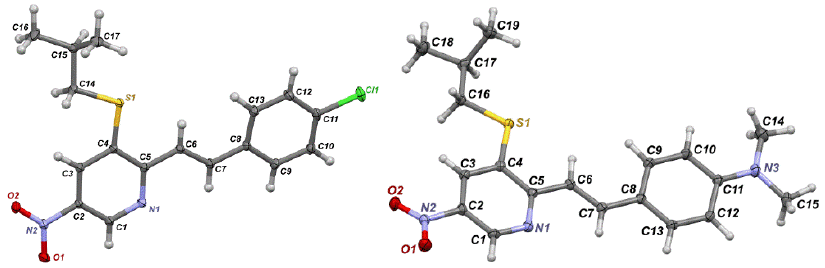
Figure 3. Cross-peaks observed in 1 Н - 1 Н NOESY spectrum of compounds 5m (R 1 = NO 2 ) and 5q (R 1 = Br).